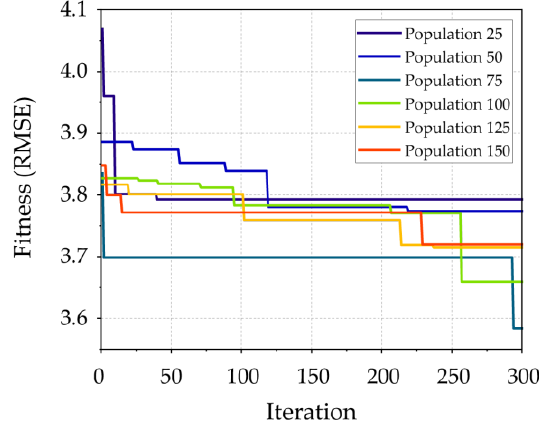
Figure 4. SOA–SVM model development.